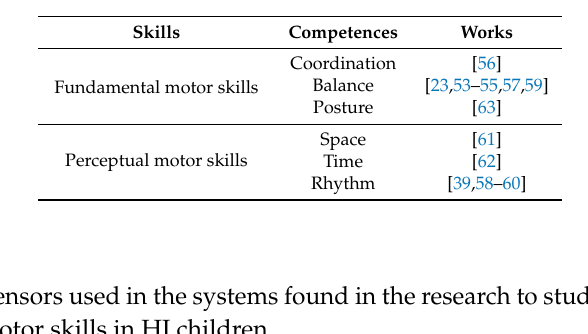
Table 1. Classification of contributions according to their impact on fundamental motor skills and perceptual motor